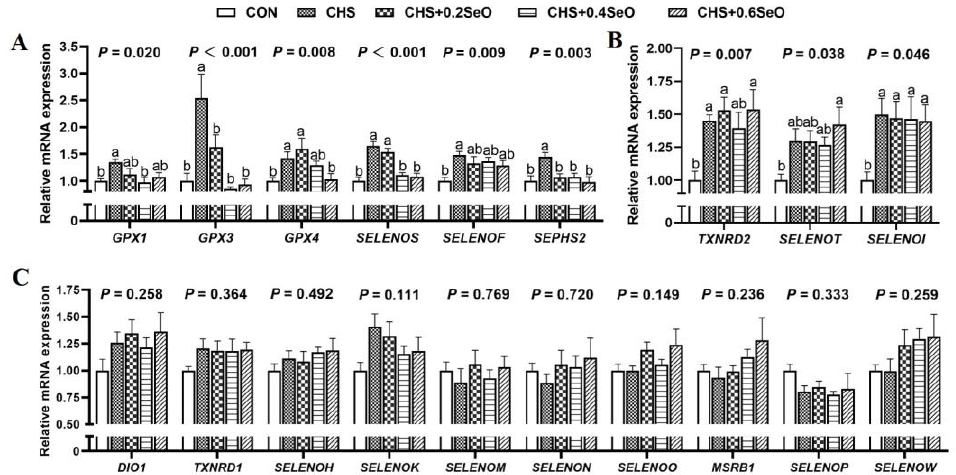
Figure 7. Effects of CHS and SeO supplementation on the mRNA expression of selenoproteins in the spleen. ( A , B ) selenoprotein genes with significant changes caused by CHS and SeO, ( C ) Genes with no significant difference. The results were expressed as mean ± SEM ( n = 6). Different letters (a and b) denote significant differences ( p <